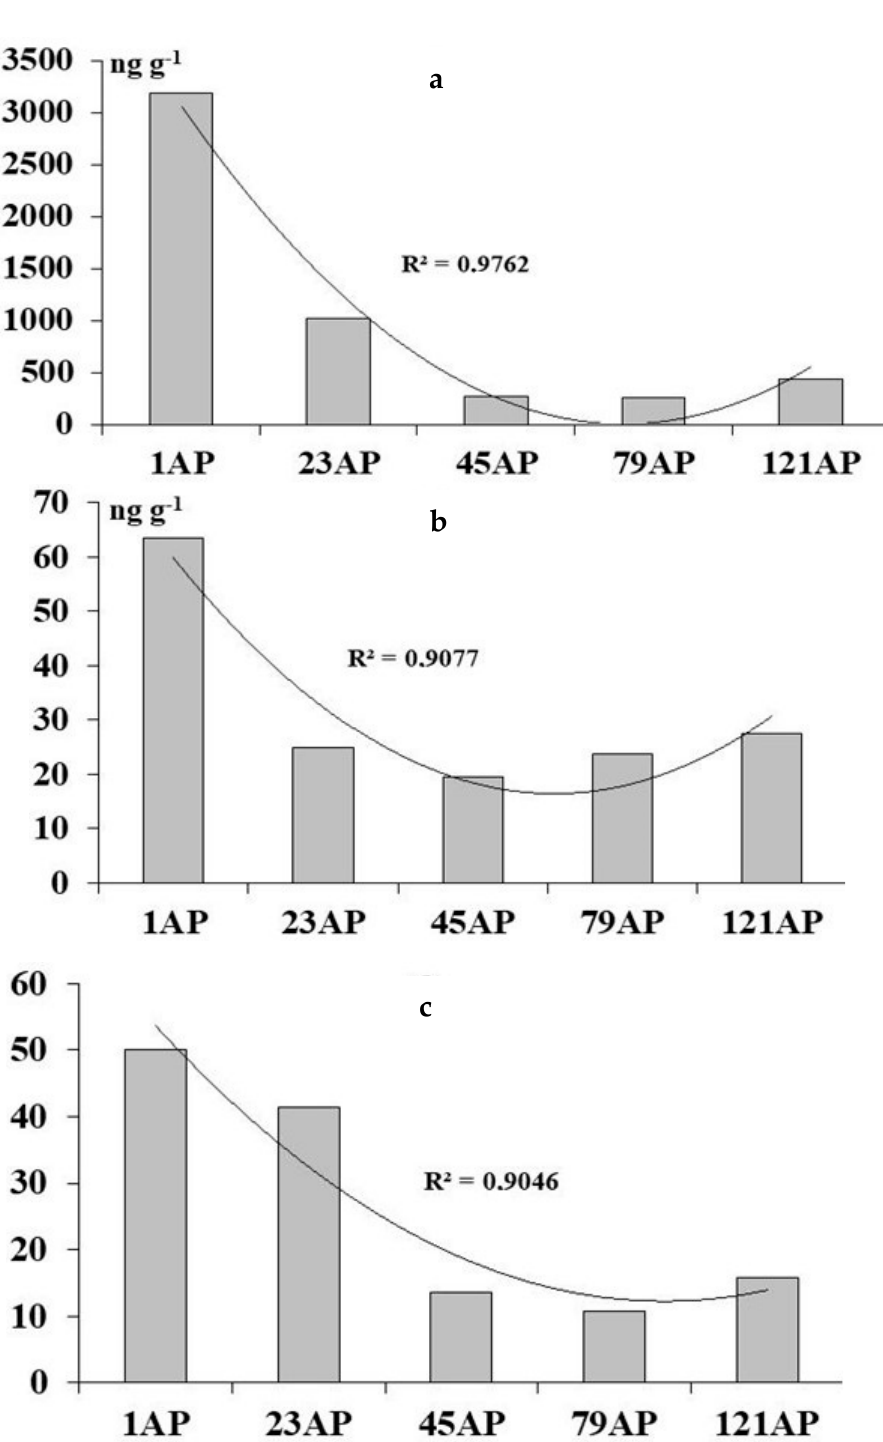
Figure 7. The total content of PAHs in the organic layer ( a ) and E pyr ( b ) of the studied soils. ( c )—index of pyrogenic activity (IPA). The trend line is polynomial.